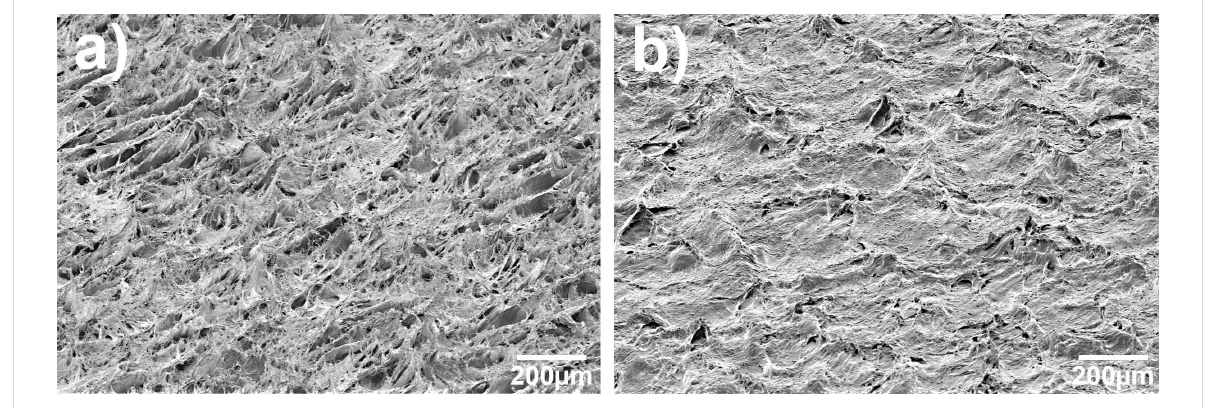
Figure 4: (a) Nanofur produced with a gap size set 50 µm below the nominal material thickness. Many long hairs are pulled out of the material. (b) Nanofur produced with a gap size set 500 µm below nominal material thickness. No hairs are pulled out of the material, the structures look as